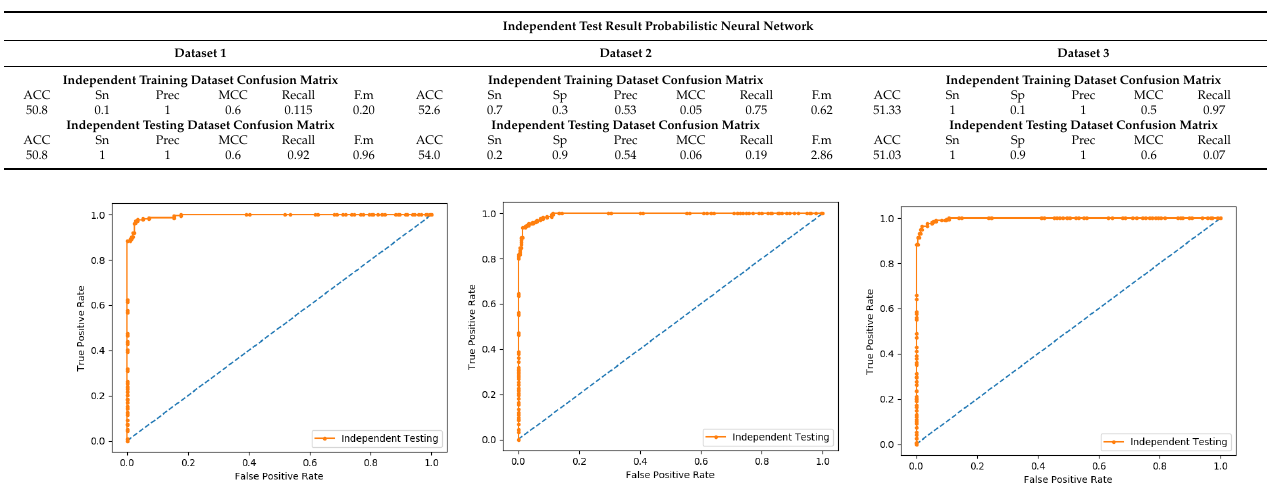
Table 9. Result of independent test based on Probabilistic Neural Network.